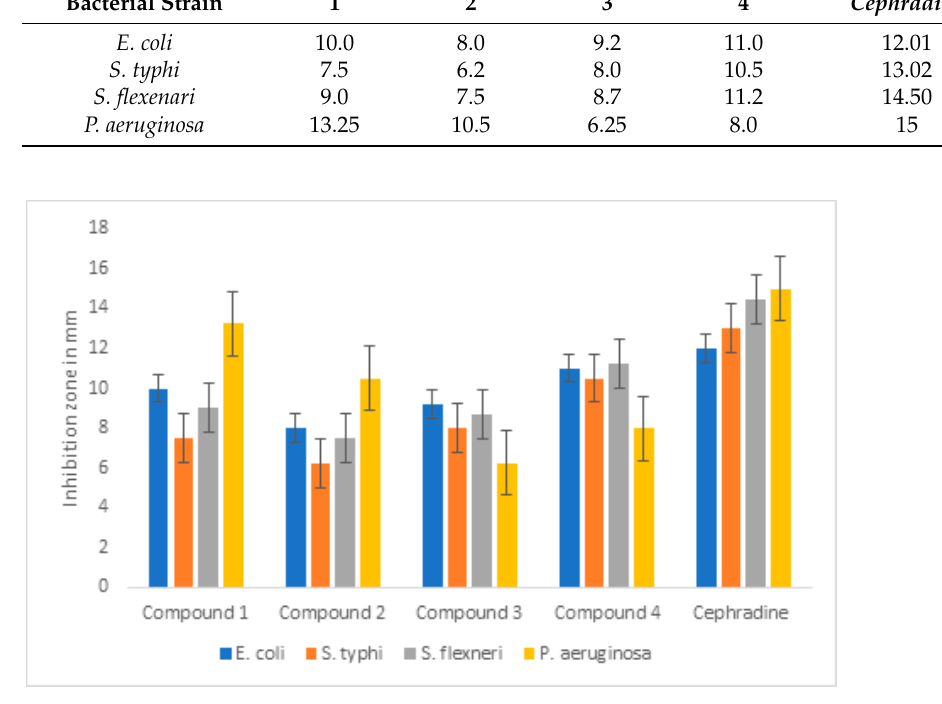
Table 4. Antimicrobial activities of compounds 1–4 , ZI were measured in mm.